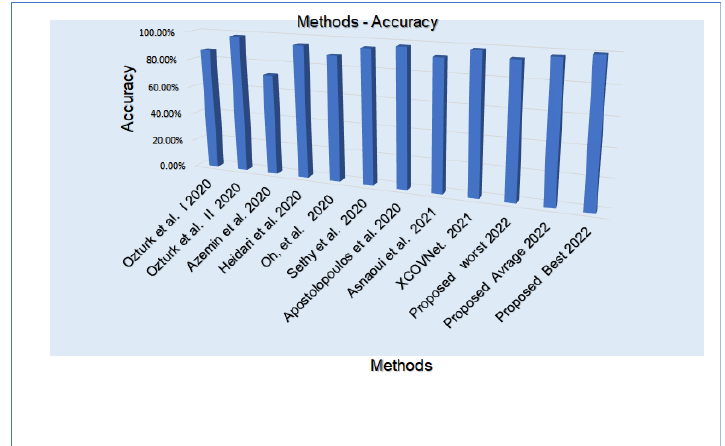
Figure 20. Methods and accuracy. Methods (X-axis) see Table